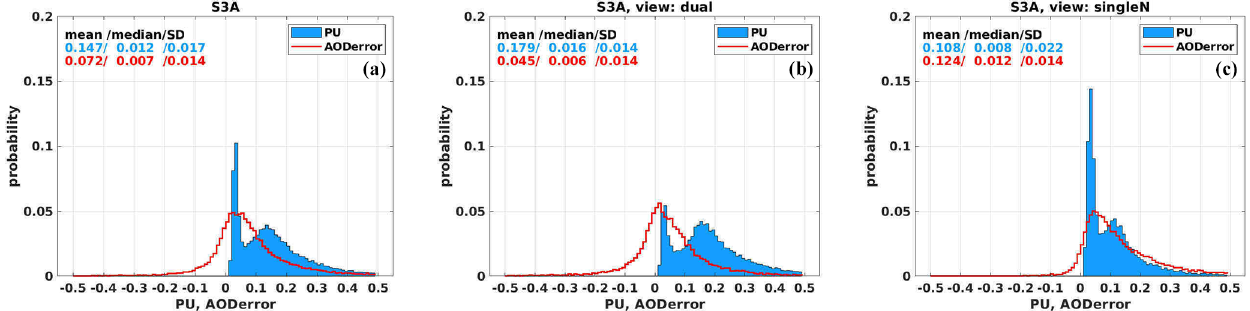
Figure 15. Comparison between PU, AOD error distribution, and theoretical Gaussian distribution for the whole product (a) as well as dual (b) and singleN (c) groups of matchups.